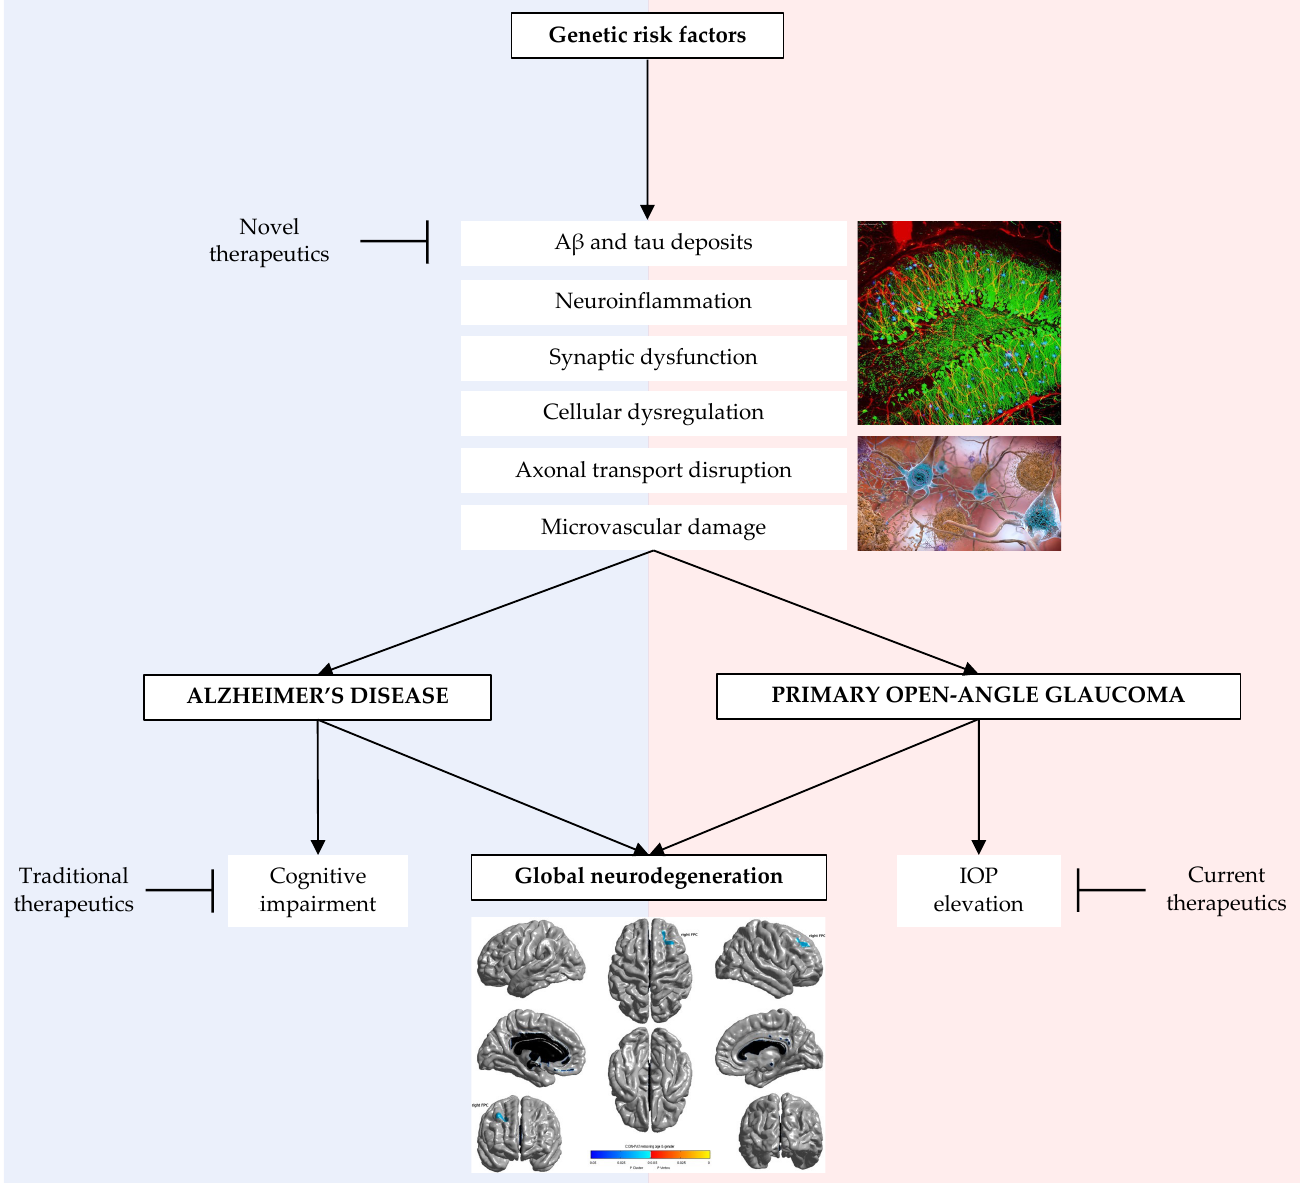
Figure 1. Depiction of the pathologic commonalities between Alzheimer’s disease and primary open-angle glaucoma [18–20]. A β = amyloid beta; IOP = intraocular